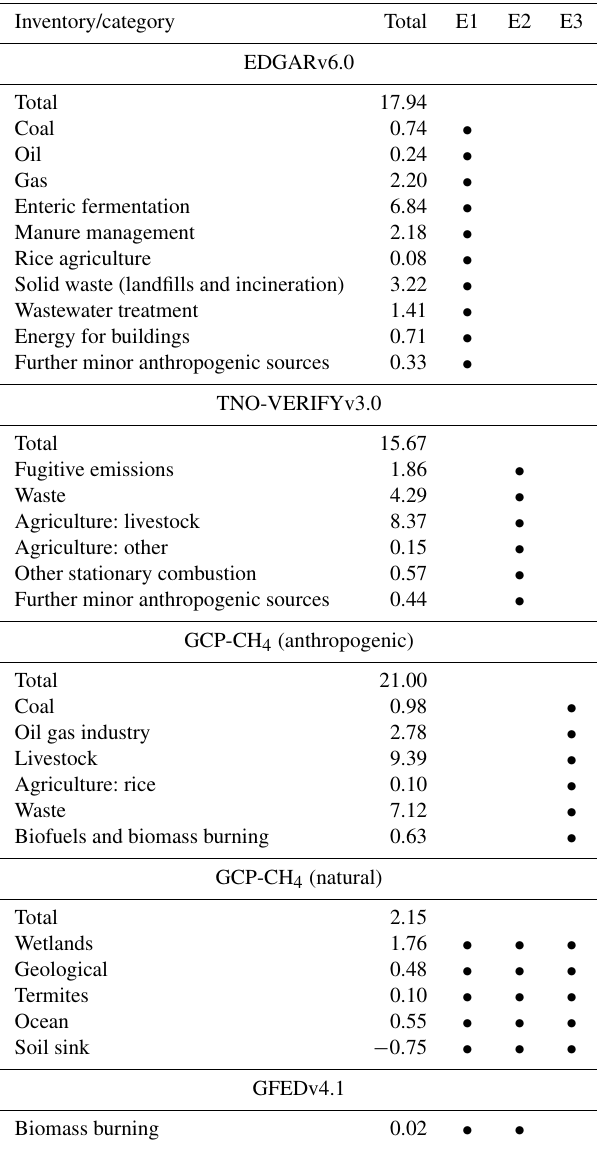
Table 2. Emission inventories used in this study. The second col- umn (“Total”) lists the total CH 4 emissions over the COSMO-7 do- main in units of teragrams of methane per year (TgCH 4 yr − 1 ) for the individual categories and the totals of each inventory. The last three columns indicate the use of the corresponding inventory data in the emission data sets E1, E2, and E3. Data for EDGARv6.0, TNO-VERIFYv3.0, and GFEDv4.1 are for 2018, and GCP-CH 4 (anthropogenic) data are for 2017, while GCP-CH 4 (natural) data represent climatological mean